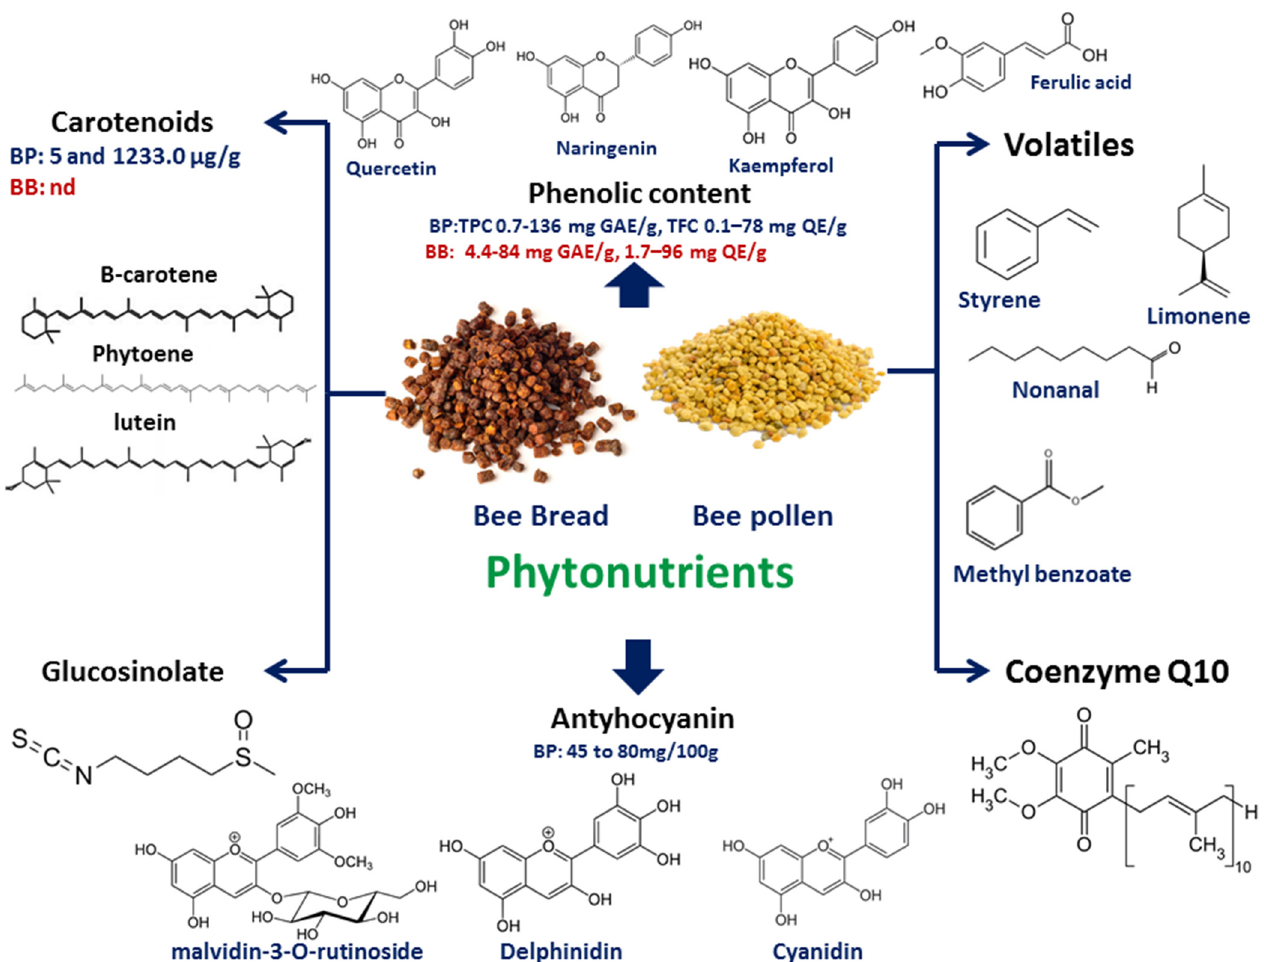
Figure 2. Major phytonutrients identified in both BP and BB, including phenolics, anthocyanins, carotenoids, glucosinolates, coenzyme Q10, and volatiles.